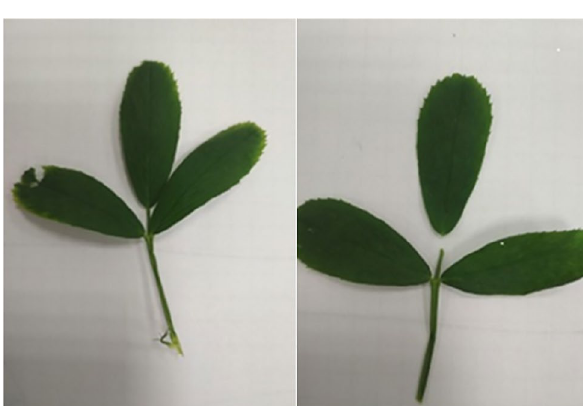
Figure 4. A leaf before and after tensioning. Photo by Agata